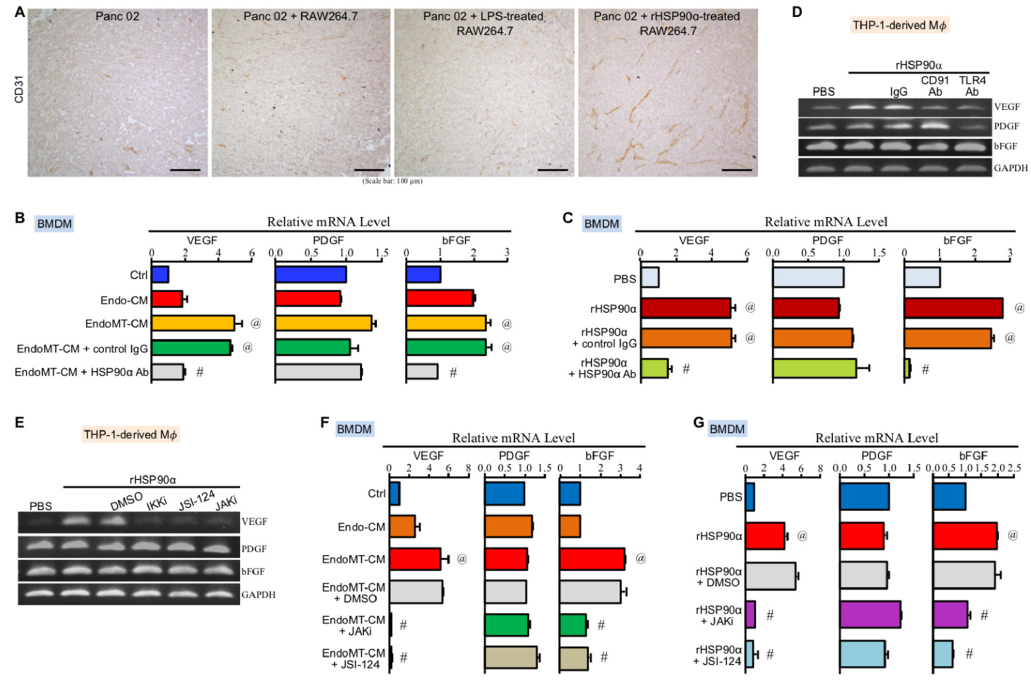
Figure 6. The MyD88–JAK2/TYK2–STAT-3 axis is involved in eHSP90 α -induced proangiogenic activity of M2-type macrophages. ( A ) IHC of CD31 from the tumors formed by Panc 02 cells alone or Panc 02 cells mixed with PBS-, LPS-, or rHSP90 α -treated BMDMs. ( B ) mRNA levels of VEGF, platelet-derived growth factor (PDGF), and bFGF in the BMDMs treated for 24 h with control medium (Ctrl), Endo-CM, EndoMT-CM, or EndoMT-CM plus control IgG or anti-HSP90 α antibody. The mean ± SD of qPCR data were obtained from three independent experiments. @ p < 0.01 when compared with “Ctrl” group. # p < 0.01 when compared with “EndoMT-CM + control IgG” group. ( C ) mRNA levels of VEGF, PDGF, and bFGF in the BMDMs treated for 24 h with PBS, rHSP90 α , or rHSP90 α plus control IgG or anti-HSP90 α antibody. The qPCR data shown are the mean ± SD of three independent experiments. @ p < 0.01 when compared with “PBS” group. # p < 0.01 when compared with “rHSP90 α + control IgG” group. ( D ) mRNA levels of VEGF, PDGF, and bFGF in the THP-1-derived macrophages treated for 24 h with PBS, rHSP90 α , or rHSP90 α plus control IgG or anti-CD91 or TLR4 antibody. The representative RT-PCR data of three independent experiments are shown. ( E ) mRNA levels of VEGF, PDGF, and bFGF in the THP-1-derived macrophages treated for 24 h with PBS, rHSP90 α , or rHSP90 α plus DMSO, IKKi, JSI-124, or JAKi. The RT-PCR data shown are the representative of three independent experiments. ( F ) mRNA levels of VEGF, PDGF, and bFGF in the BMDMs treated for 24 h with control medium (Ctrl), Endo-CM, EndoMT-CM, or EndoMT-CM plus DMSO, JAKi, or JSI-124. The qPCR data shown are the mean ± SD of three independent experiments. @ p < 0.01 when compared with “Ctrl” group. # p < 0.01 when compared with “EndoMT-CM + DMSO” group. ( G ) mRNA levels of VEGF, PDGF, and bFGF in the BMDMs treated for 24 h with PBS, rHSP90 α , or rHSP90 α plus DMSO, JAKi, or JSI-124. The qPCR data shown are the mean ± SD of three independent experiments. @ p < 0.01 when compared with “PBS” group. # p < 0.01 when compared with “rHSP90 α + DMSO”